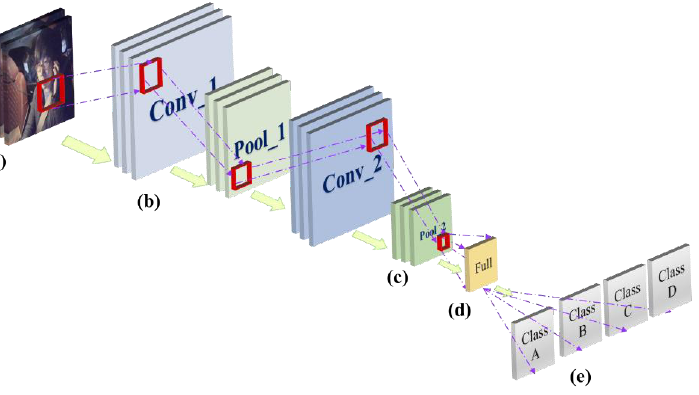
Figure 1. Convolutional neural network architecture: ( a ) input layer; ( b ) convolutional layer; ( c ) pooling layer; ( d ) fully connected layer; ( e ) classification layer.